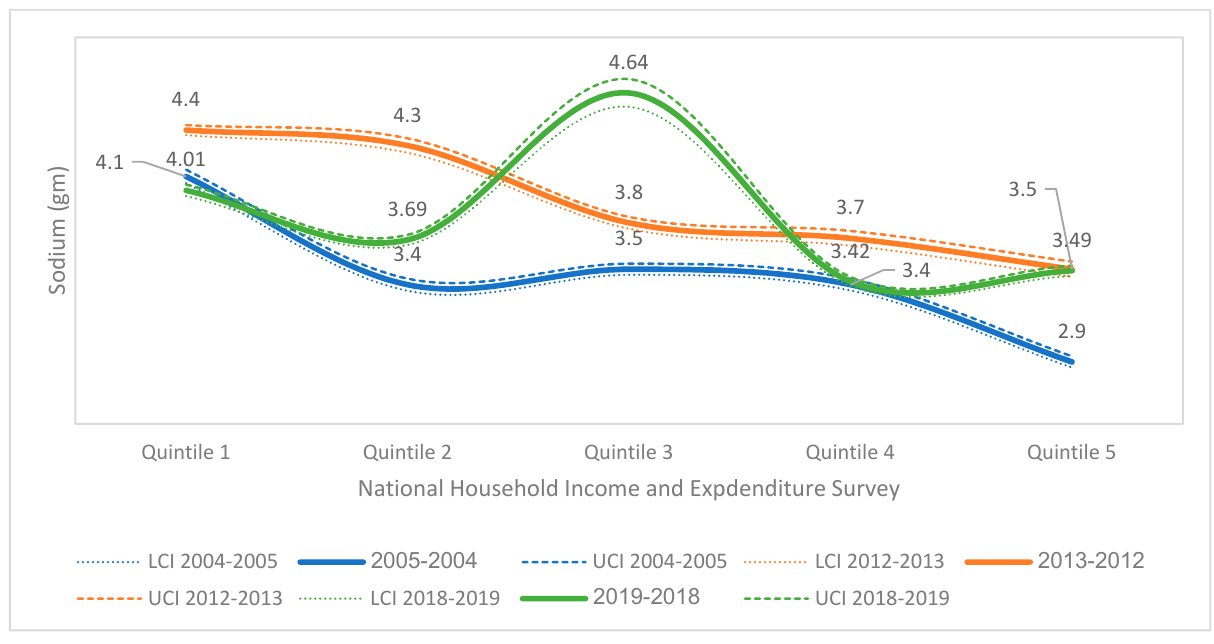
Figure 3. Sodium availability for household consumption by income quintile in Costa Rica during 2004–2005, 2012–2013 and 2018–2019 (g/person/day adjusted to 2000 kcal/day). LCI = lower limit of the confidence interval. UCI = upper limit of the confidence interval. Sodium sources analyzed in all three surveys are shown in Figure 4. Common salt was the main source providing more than 60% and showing an increasing trend in 2018– 2019, followed by the group of processed and UP foods with added sodium which also show a statistically significant ( p < 0.05) increasing trend in the last two surveys. Condi- ments with added sodium are the third contributor, even though for the 2018–2019 survey there was a decrease compared to the 2012–2013 survey. The least contributing source was the prepared dishes group, while in the previous surveys (2004–2005 and 2012–2013) nat- ural and processed foods without added sodium took this place.